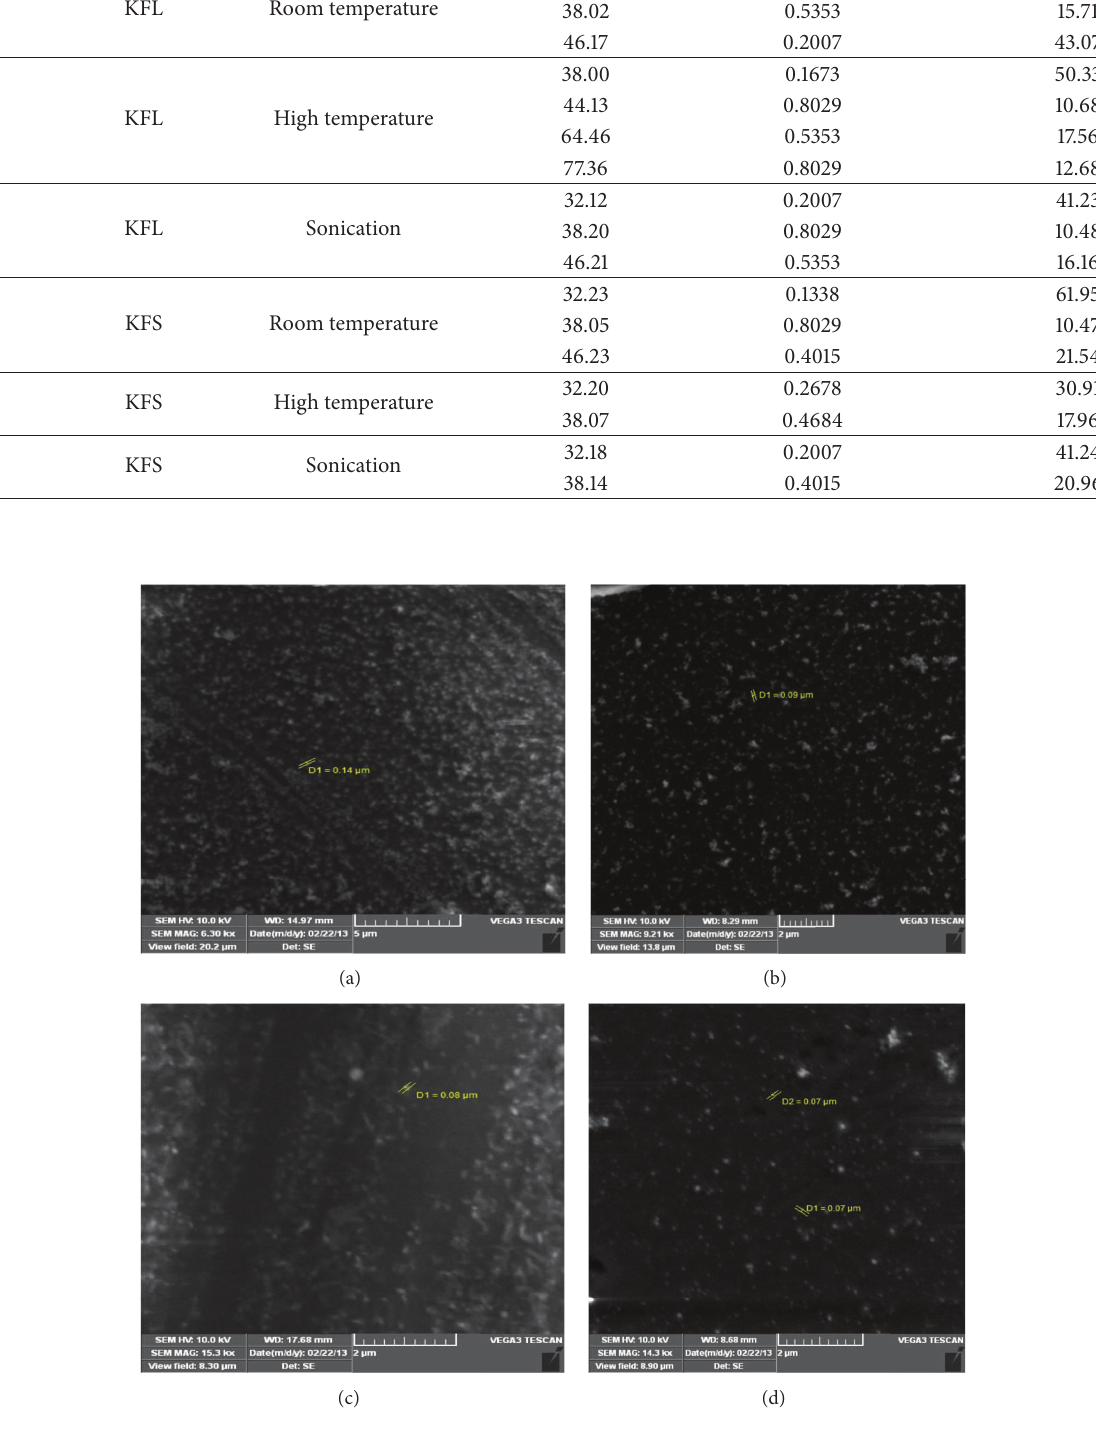
Figure 4: SEM micrographs of nanosilver synthesized using KFL and KFS extracts under room temperature (a) and (b) and sonication (c) and (d),